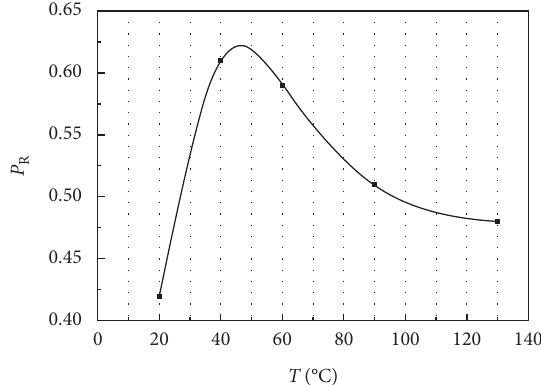
Figure 10: Brittleness index P f of rocks at different temperatures [50].